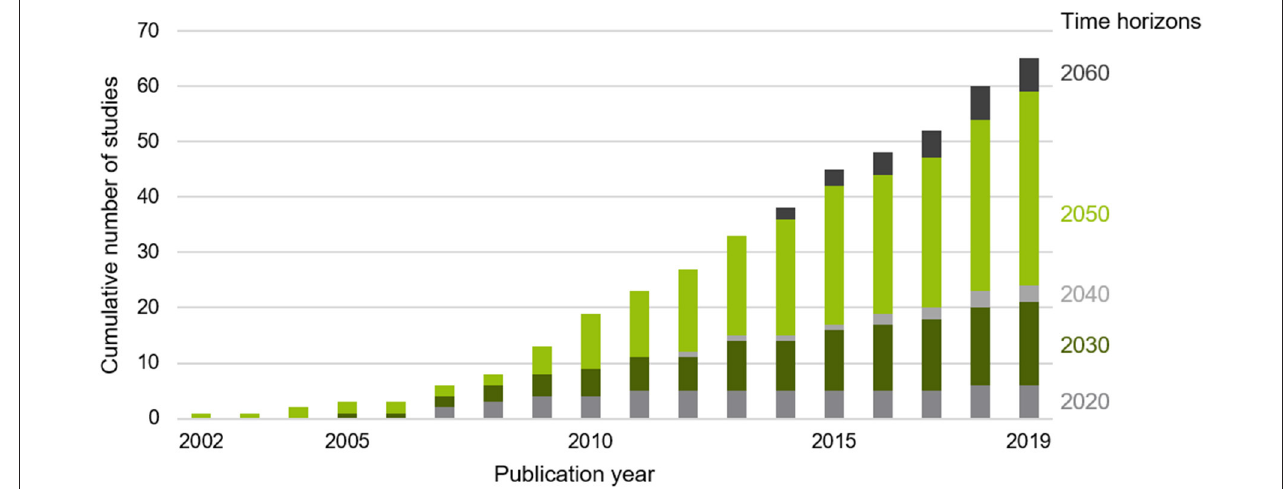
FIGURE 2 | Publication dynamics of German scenario studies for different time